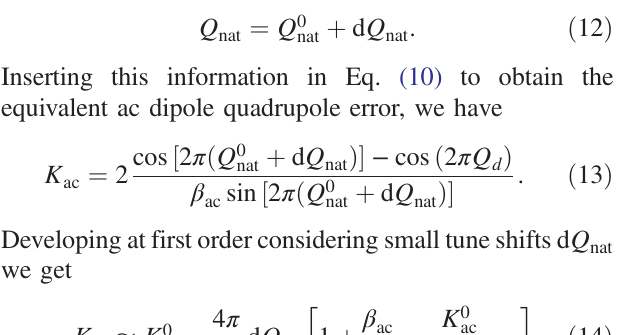
ac dipole location as expected from Eq. (17).